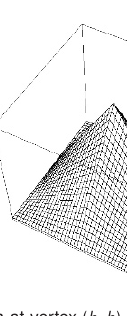
Figure 1. φ 0 ( x,y ) on its support [0 , 2 h ] × 2 with maximum at vertex ( h,h ) . Hence, with this choice, we have